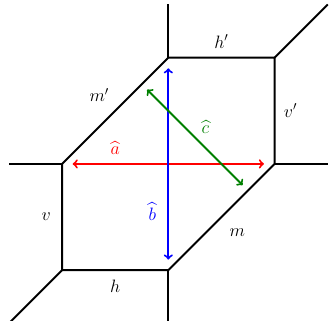
Figure 4 . Three classes of curves within a given hexagon S i whose areas are identi(cid:12)ed with roots in the gauge theory